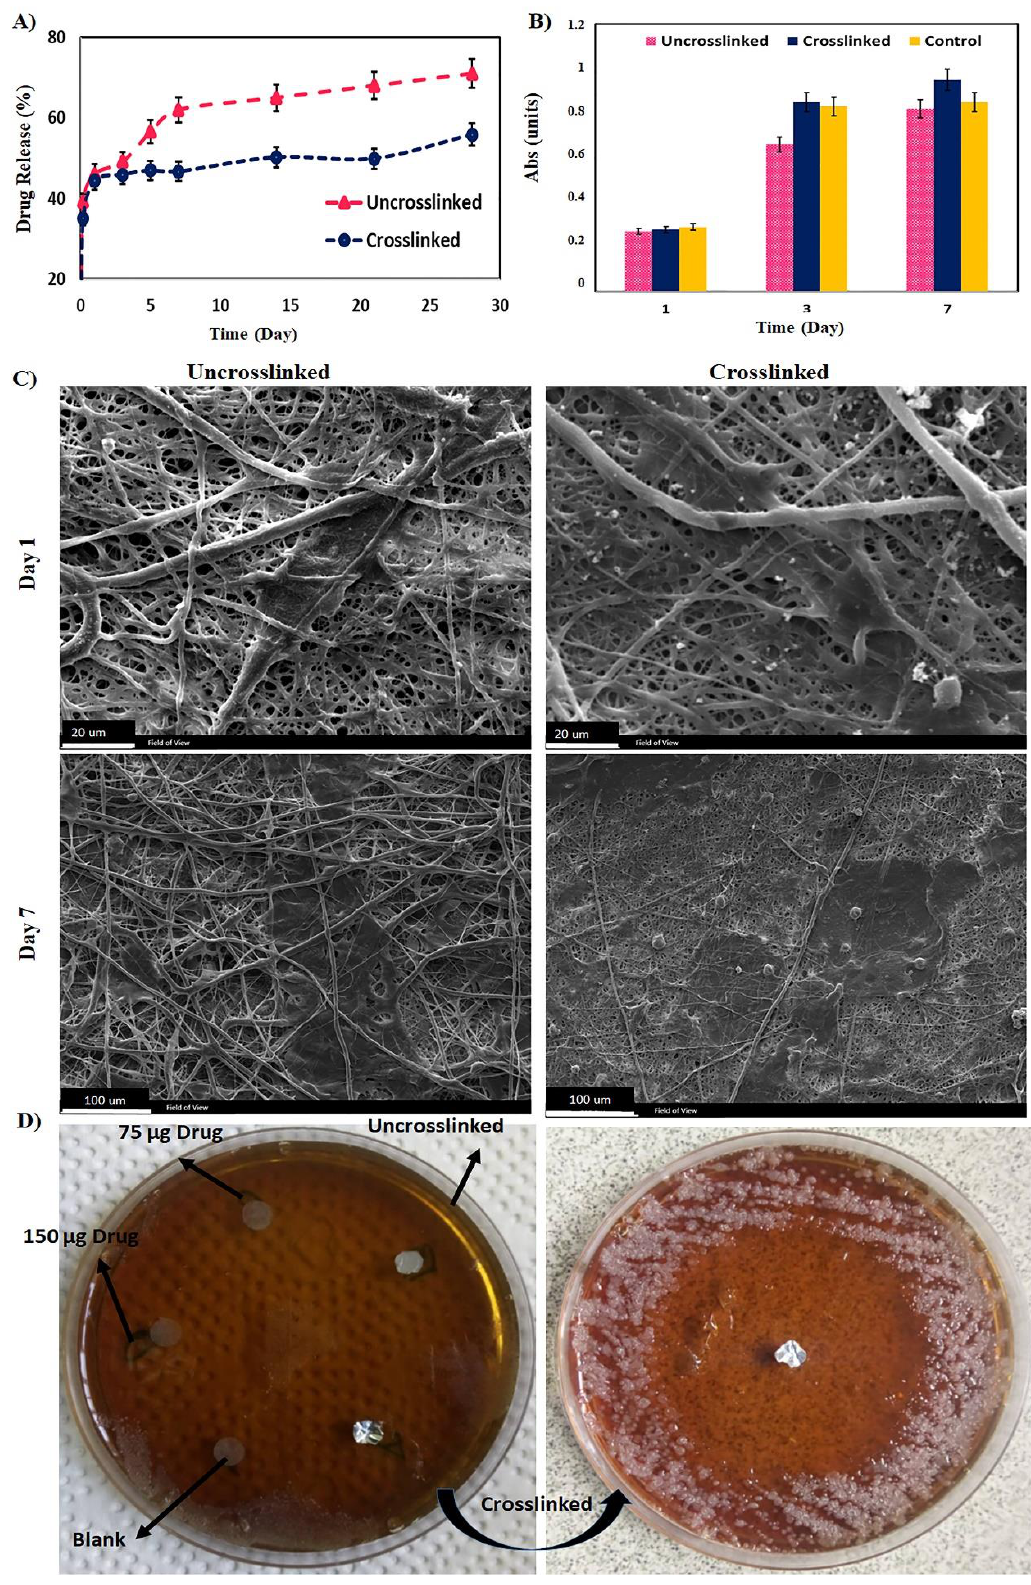
Figure 3. ( A ) The cumulative release of ciprofloxacin from the scaffolds before and after crosslinking; ( B ) the MTT results; ( C ) the SEM micrographs of the scaffolds (scale bar = 20 and 100 µ m); ( D ) the antibacterial activity of the prepared scaffolds.